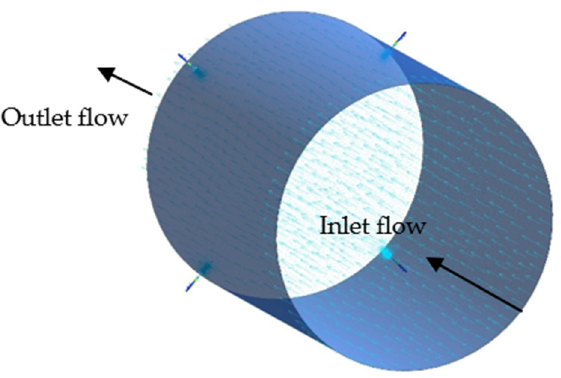
Figure 6. CFD, Post-processing. High-pressure section: Isometric view.